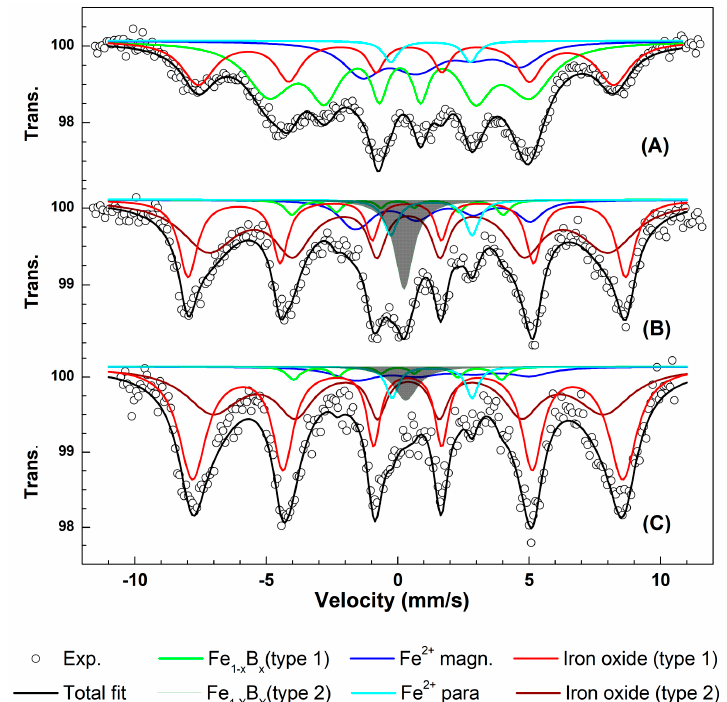
Figure 5. Examples of 57 Fe Mössbauer spectra at 5 K for ( A ) MMT-Fe, ( B ) fresh LLDPE.Fu15%.MMT- Fe6.25%, and ( C ) LLDPE.Fu15%.MMT-Fe6.25% exposed to ambient air for four months.